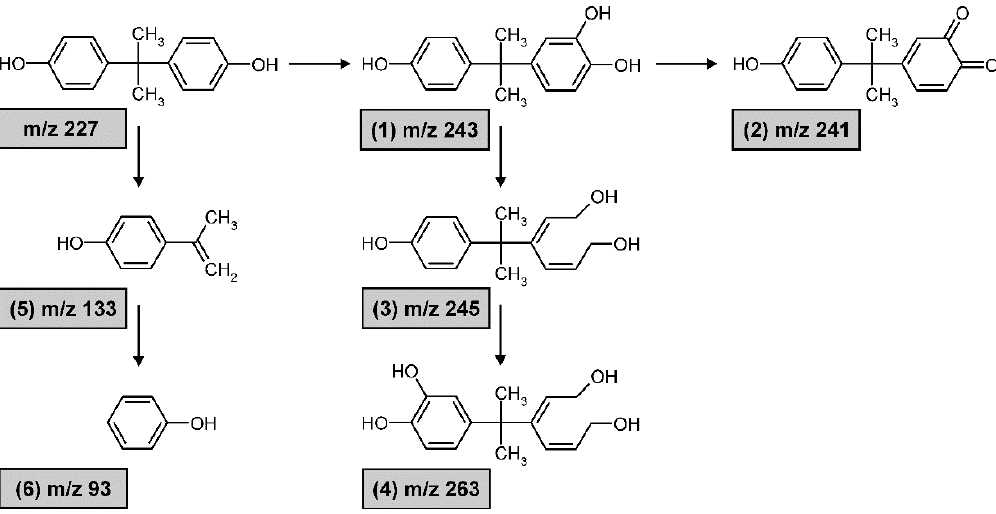
Figure 6. BPA and degradation products identified in its Ag-TiO 2 -supported photodegradation.